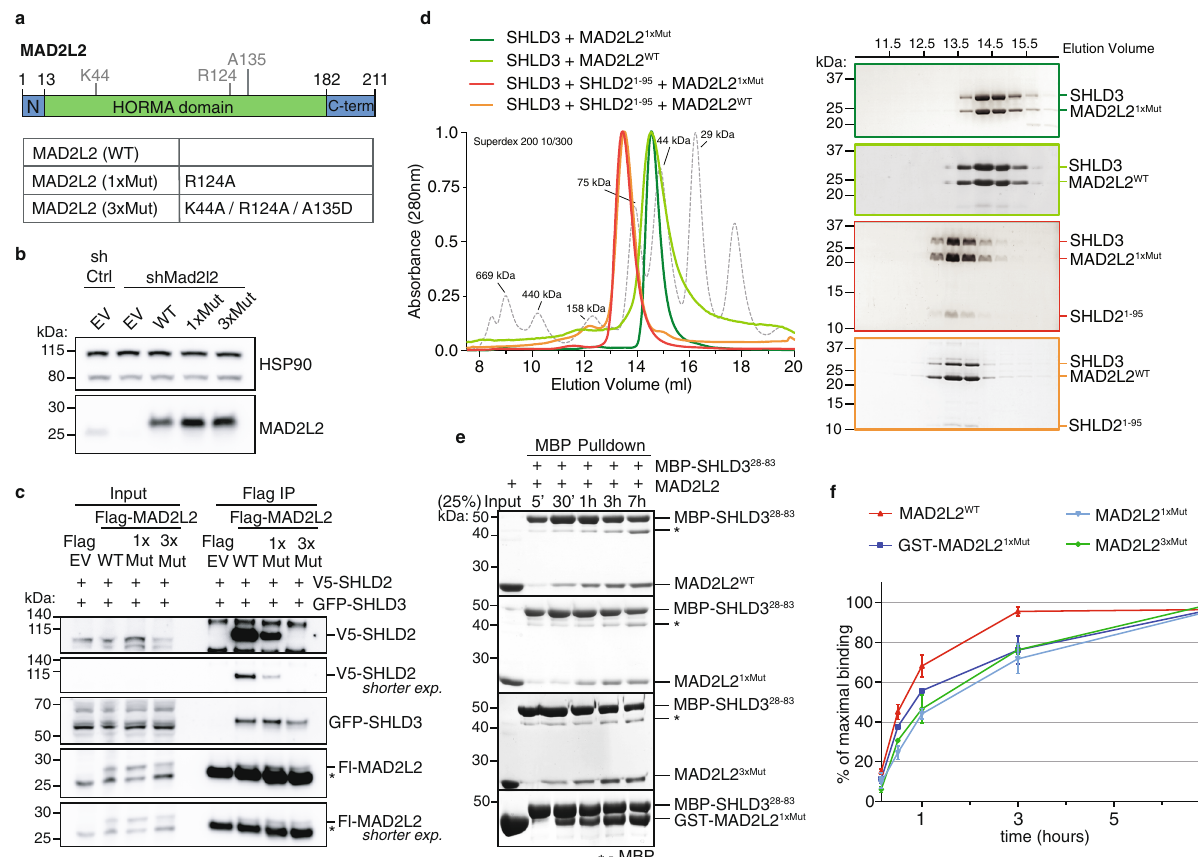
Fig. 1 MAD2L2 forms a dimer mediated by SHLD2 that is important for shieldin assembly. a Schematic representation of the MAD2L2 protein with residues mutated to abolish dimerization. b Immunoblot of TRF2ts MEFs transduced with indicated shRNAs, complemented with shRNA-resistant expression constructs (EV, empty vector control; WT, full-length wild-type MAD2L2; 1xMut and 3xMut as indicated in a , all with single Flag-tag). HSP90 serves as loading control. c Immunoblot of 293T cells transfected with indicated epitope-tagged constructs followed by Flag immunoprecipitation. V5-SHLD2 is detected with V5-antibody, GFP-SHLD3 with GFP-antibody and Flag-MAD2L2 (Fl-MAD2L2) with MAD2L2-antibody. Asterisk denotes immunoglobulin light-chain. Representative of three independent experiments. d SHLD2 1-95 induces dimerization of MAD2L2-SHLD3 complex. Coomassie- stained SDS-PAGE gels of SEC-pro fi les of SHLD3-MAD2L2 complex (WT: light green, 1xMut: dark green) and SHLD3-SHLD2 1-95 -MAD2L2 complex (WT: red, 1xMut: orange). Shift in elution-pro fi le indicates an apparent increase of molecular weight of ~54 to ~90 kDa upon addition of SHLD2 1-95 . Molecular weight of MAD2L2 is 25 kDa, of SHLD3 is 29 kDa and of SHLD2 1-95 is 11 kDa. e Time course of shieldin assembly between components MAD2L2 and SHLD3 shows that assembly of SHLD3-MAD2L2 complex is slow, but accelerated by MAD2L2 dimerization. Coomassie-stained SDS-PAGE gels show a time course of pulldowns of MBP-SHLD3 (bait) and MAD2L2-variants (prey). The SHLD3-fragment used here contains only the second RBM, which is captured by the seatbelt of MAD2L2 29 . A single-point mutation at R124 (1xMut) hinders MAD2L2 dimerization and subsequently lowers binding kinetics. Triple mutation of residues K44, R124, and A135 (3xMut) in the dimerization interface of MAD2L2 has the same effect as 1xMut on binding kinetics. Inducing dimerization by creating GST-fusion partially rescues the assembly kinetics. Representative of n = 4 (MAD2L2 WT /MAD2L2 1 x M ut ) or n = 2 (MAD2L2 3 x M ut /GST-MAD2L2 1 x M ut ). f Graphical representation of data in e . Red curve represents binding kinetics between MAD2L2 WT and SHLD3 28-83 peptide. Light blue and green curves represent the reduction in binding kinetics of MAD2L2 1 x M ut and MAD2L2 3 x M ut with SHLD3 28-83 . Dark blue curve represents partial restoration of binding kinetics between MAD2L2 1 x M ut and SHLD3 28-83 induced by dimerization of the GST-tag. Graphs represent mean ± s.e.m, n = 4 for MAD2L2 WT /MAD2L2 1 x M ut , n = 2 for MAD2L2 3 x M ut /GST-MAD2L2 1 x M ut . Source data are provided as a Source Data fi